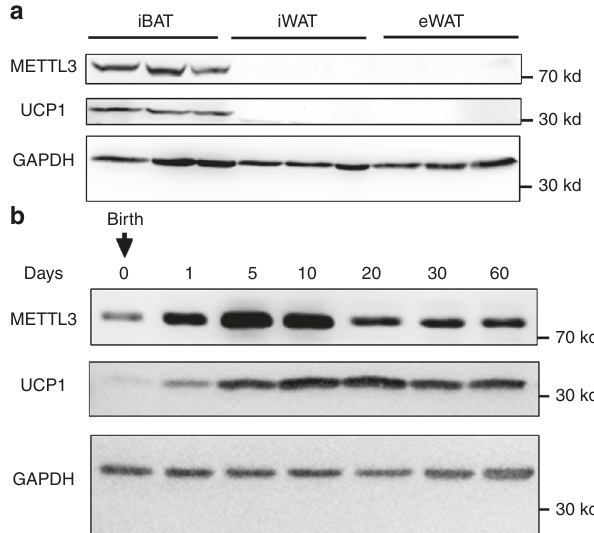
Fig. 1 METTL3 is enriched in iBAT and associated with postnatal development of iBAT. a METTL3 and UCP1 protein levels in iBAT, iWAT, and eWAT of C57BL/6 male mice at 8 weeks of age. b METTL3 and UCP1 protein levels in iBAT at 0, 1, 5, 10, 20, 30, and 60 days after birth. These experiments were repeated three times independently with similar results. Source data are provided as a Source Data fi